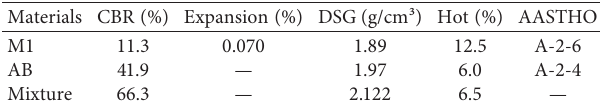
Table 3: Results of the characterization tests of the collected materials.